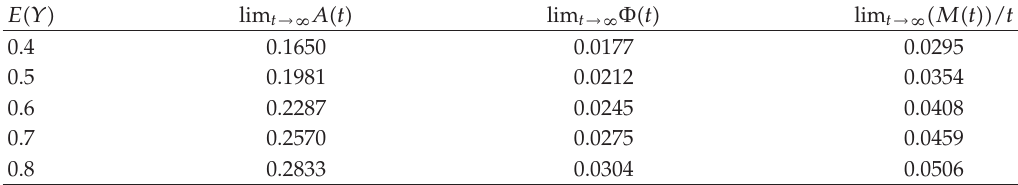
Table 1: Reliability indices for varying value of E (cid:2) Y (cid:5) with (cid:2) α,E (cid:2) B (cid:5)(cid:5) (cid:8) (cid:2) 0 . 2 , 0 . 6 (cid:5) .